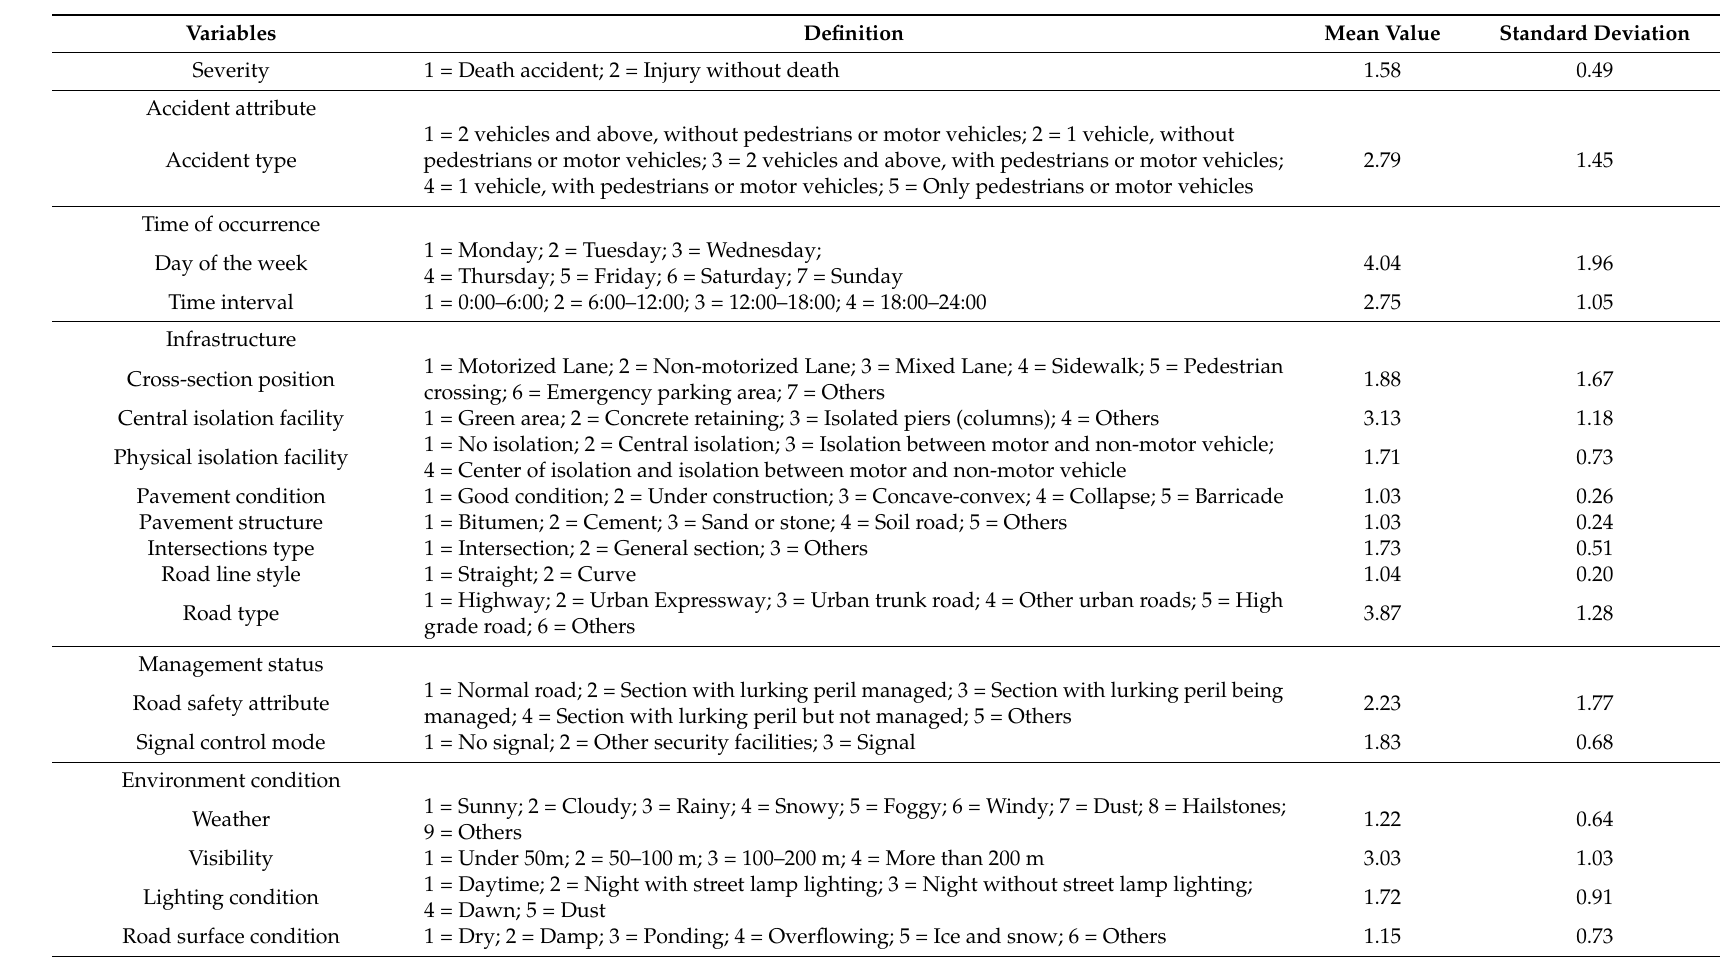
Table 2. Definitions and descriptive